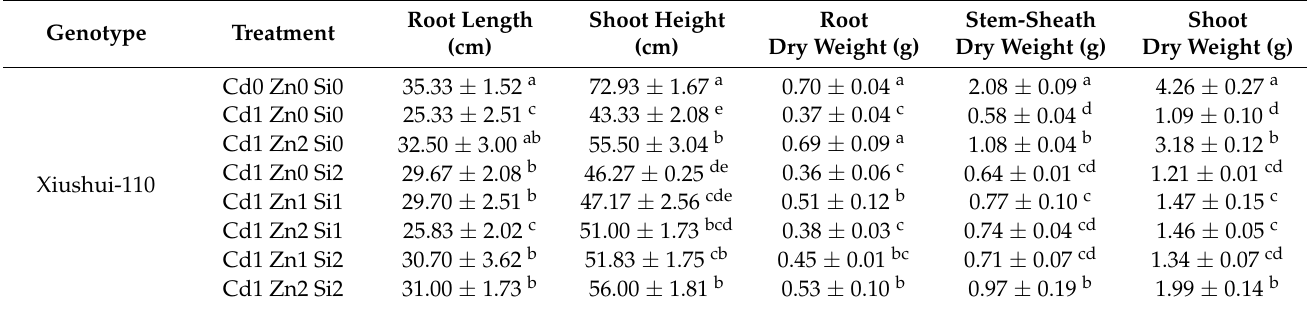
Table 1. Effect of alone and combined cadmium, zinc, and silicon application (30 d) on plant growth parameters for two rice